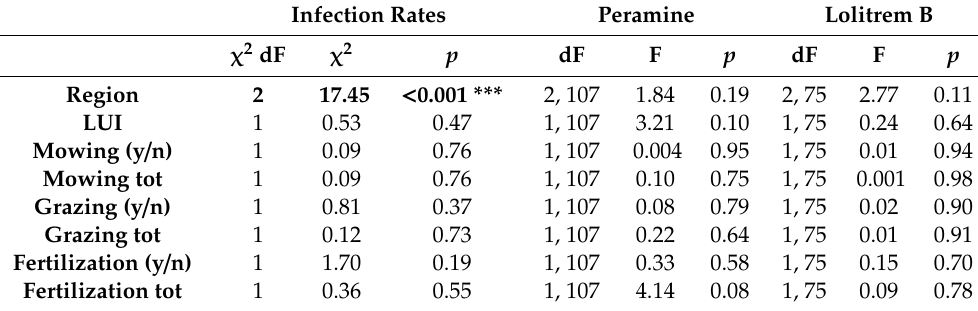
Table 1. Generalized linear models (infection rates) and linear mixed e ff ect models (peramine and lolitrem B). For the alkaloid concentrations (peramine and lolitrem B), only infected samples were used for analyses. LUI: land-use intensity; Mowing / Grazing / Fertilization (y / n): Mowing / Grazing / Fertilization: yes / no; Mowing tot: frequency of mowing per year; Grazing tot: the grazing intensity reflected by the density of livestock (livestock units days of grazing ha − 1 year − 1 ); Fertilization tot: fertilization level (kg nitrogen ha − 1 year − 1 ). *** = highly significant. Infection Rates